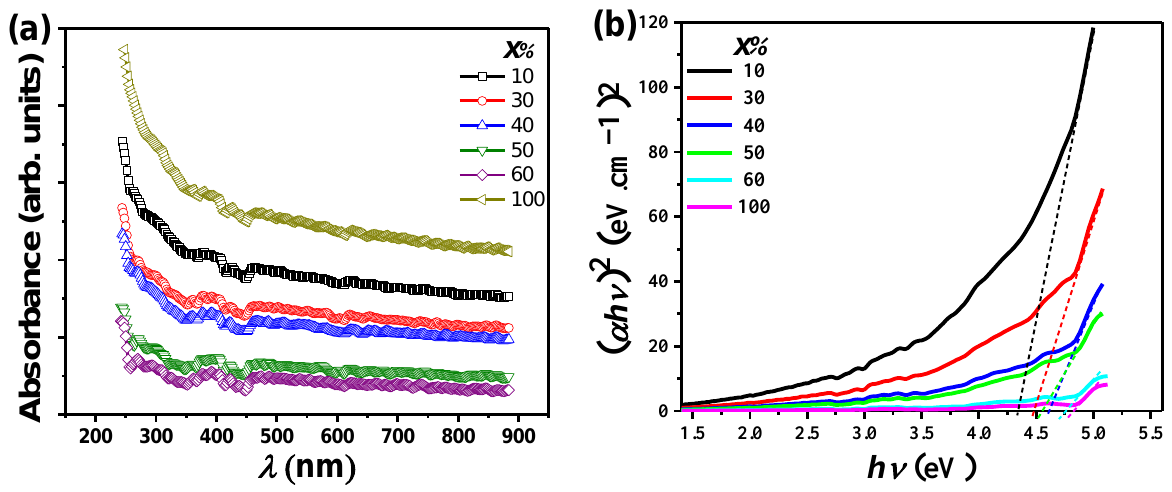
Figure 4. ( a ) UV – visible absorbance spectra versus λ , and ( b ) ( αυh ) 2 versus hυ for PbO- x %Al 2 O 3 Figure 4. ( a ) UV–visible absorbance spectra versus λ , and ( b ) ( αυ h ) 2 versus h υ for PbO- x %Al 2 O 3 composites.